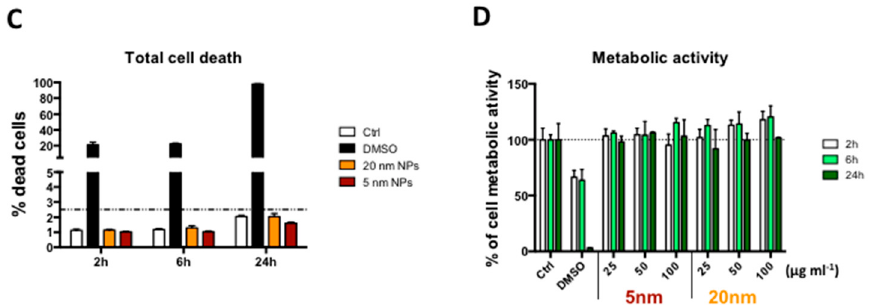
Figure 1. Cell viability. ( A – C ) Viability of THP-1 cells after 2, 6 and 24 h exposure to 50 µ g/mL PtNPs. Control columns represent untreated cells. Necrotic, apoptotic and total dead cells were evaluated by flow cytometry using the Annexin V/PI assay; ( D ) Cell metabolic activity of THP-1 cells after 2, 6 and 24 h exposure to increasing doses of PtNPs evaluated by WST-8 assay. 10% DMSO was used as positive control in all the experiments. Data are expressed in percentage relative to untreated control cells (empty columns).